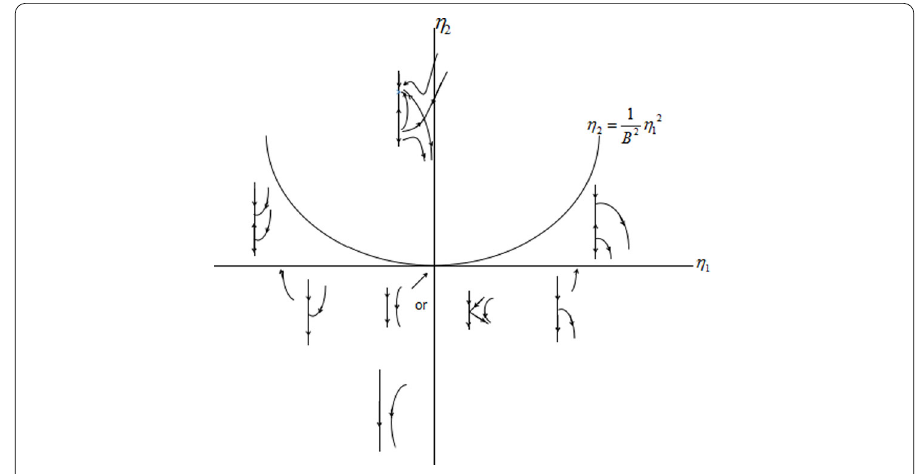
Figure 1 When B < 0, the bifurcation diagrams and phase portraits of system (3.13) (see [18])